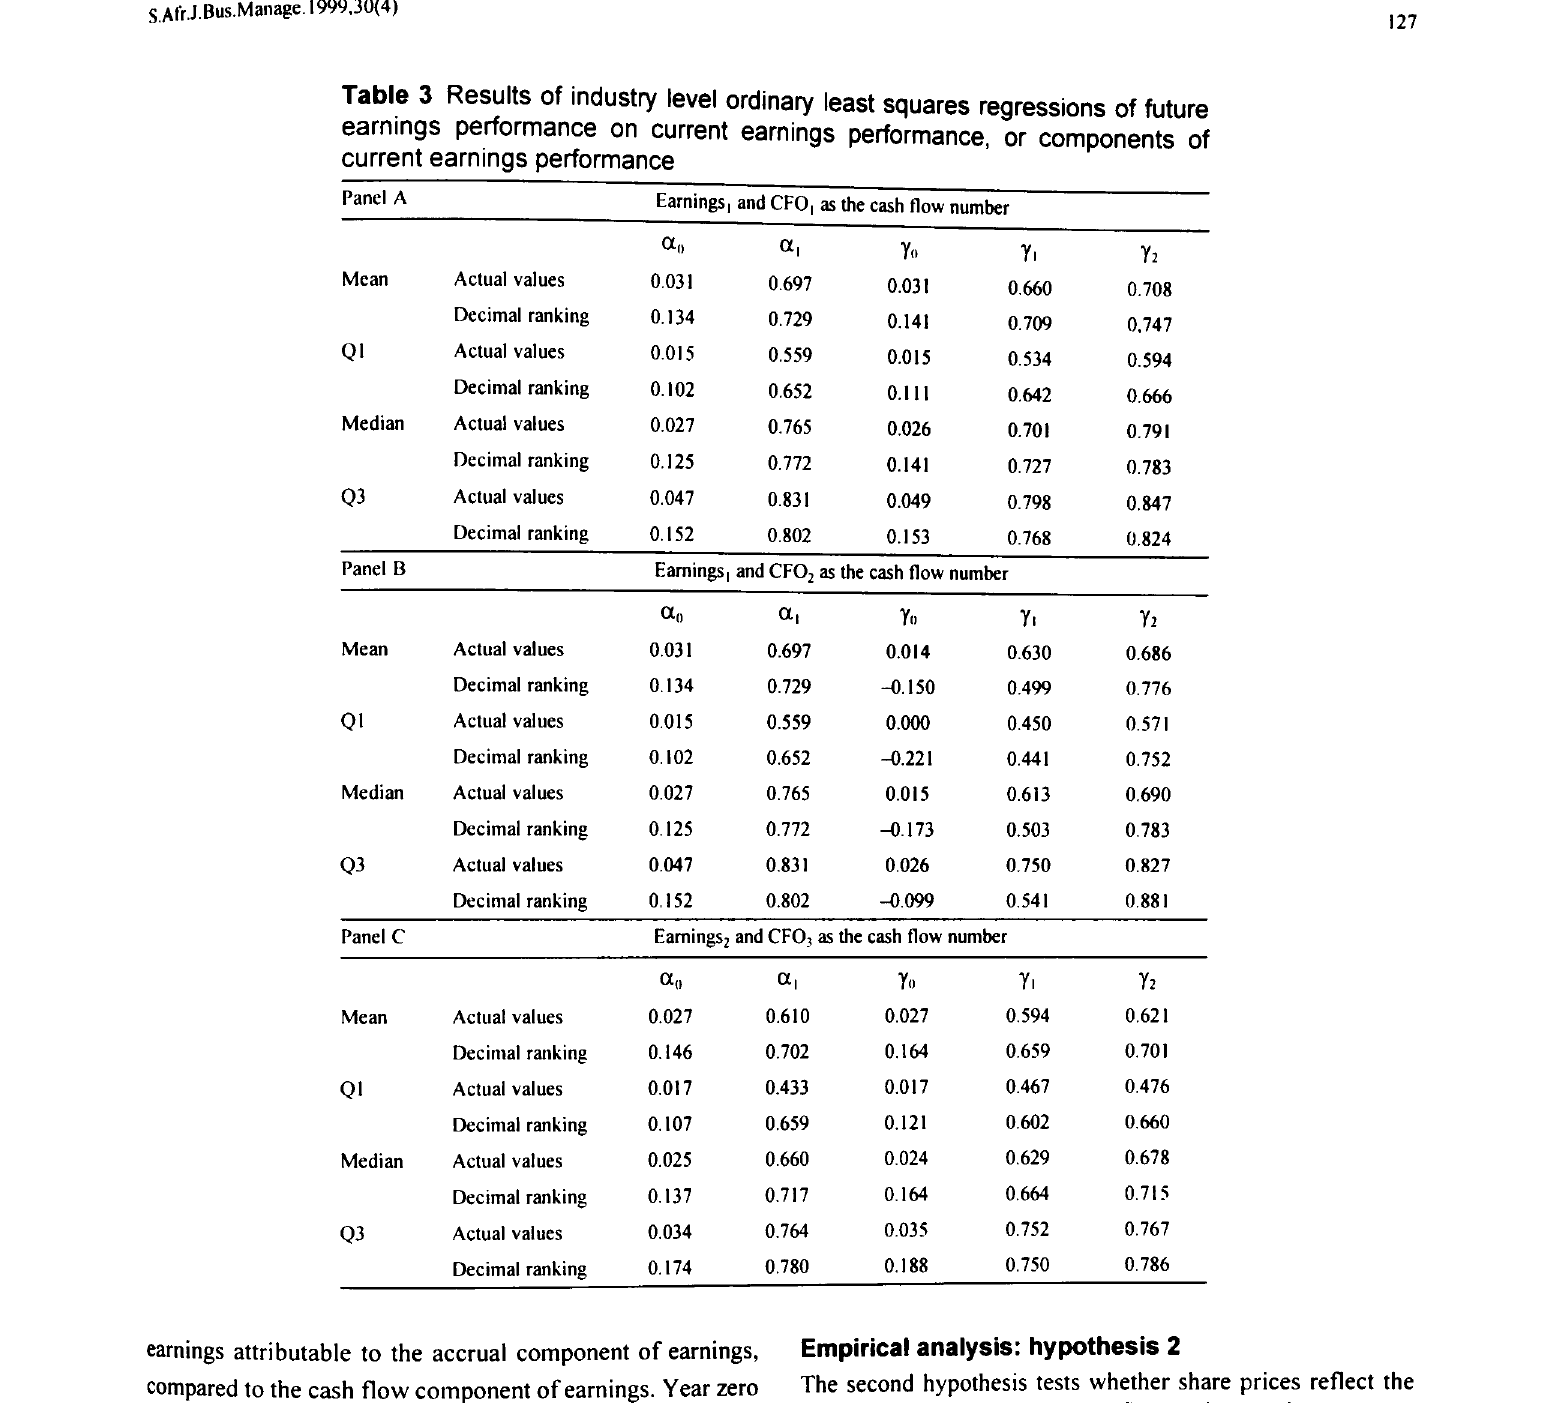
Tabl~ 3 Results of industry level ordinary least squares regressions of future earnings pe.rformance on current earnings performance, or components